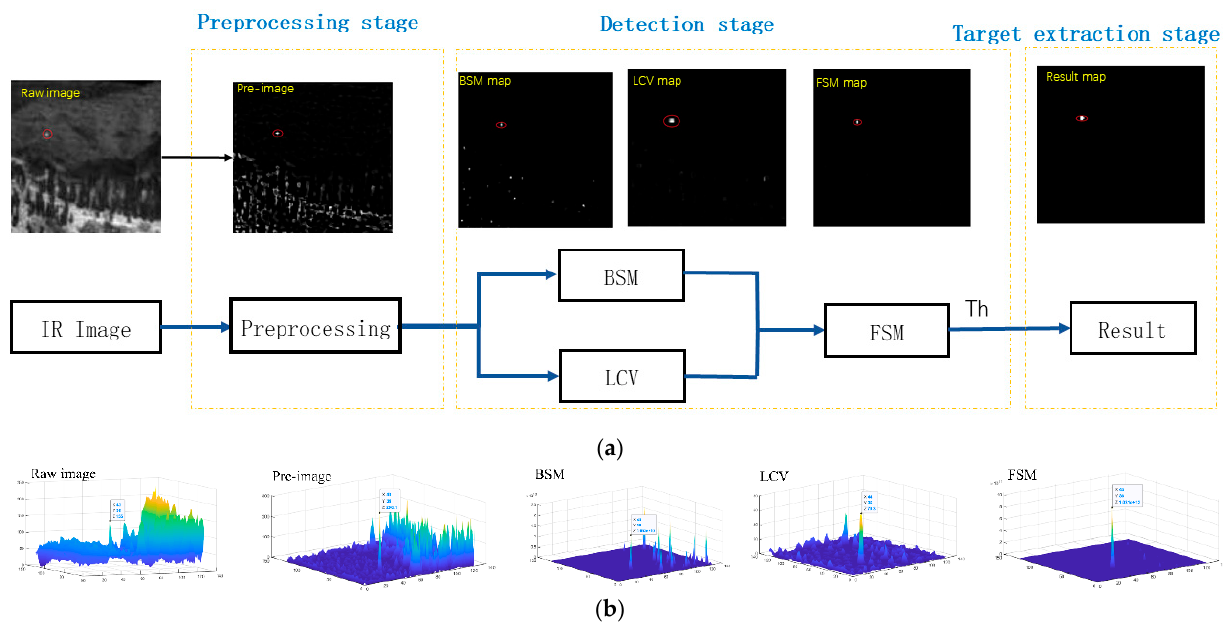
Figure 1. ( a ) The framework of our proposed method. ( b ) Three-dimensional surface after each processing.